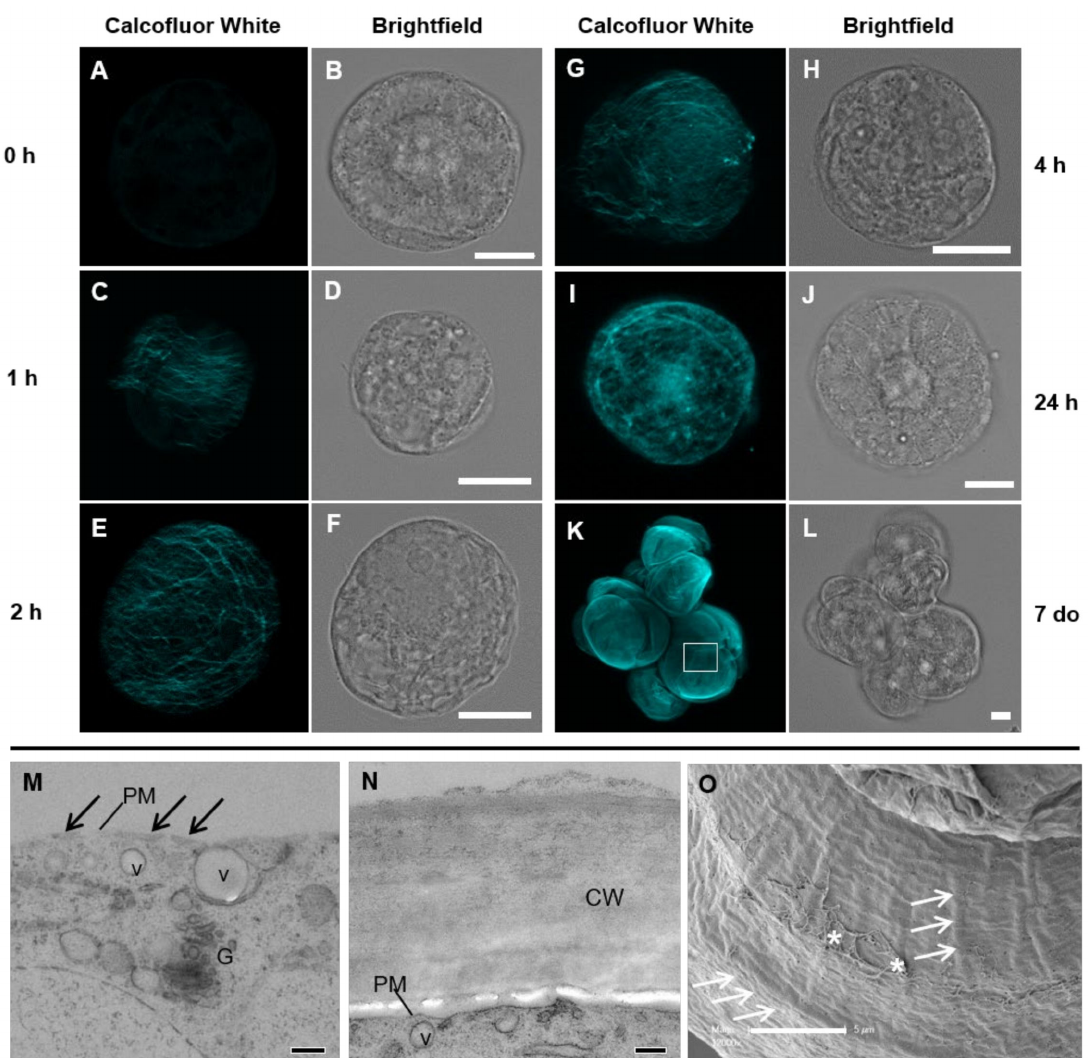
Figure 1. Images of the cell wall of Lolium suspension culture cells (SCC) during regeneration using the general cell wall stain Calcofluor White and laser scanning microscopy ( A – L ) and the cell wall detail using transmission ( M , N ) and scanning electron microscopy ( O ). The fluorescent images have had their brightness enhanced for easier visualization. Image K is a maximum projection of a z-stack of images and A, C, E, G, and I are single confocal sections of the cell wall. At the 0 h time point ( A , B ), minimal autofluorescence is observed. By 1 h ( C , D ), a number of fine filaments cover approximately half the protoplast. At 2 h ( E , F ), a loose fibrillar network encases the whole cell. At 4 h ( G , H ), the fibrillar network becomes more dense, which continues over the next 24 h ( I , J ). Actively growing Lolium SCC clump together in culture with a thick wall ( K , L ). Electron microscopy sections of the cell wall at 1 h after protoplasting ( M ) and in an unprotoplasted cell ( N ) show the difference in the cell wall structure. At 1 h, only nascent cell material is present (black arrows) at the plasma membrane (PM), while in unprotoplasted cells, the cell wall (cw) is approximately 1 µ m thick. Vesicles (v) and Golgi (G) are observed near the plasma membrane (PM). Detailed structure of the wall surface ( O ) from a position equivalent to the box in K, showing a variety of ridges (white arrows) and mucilage (asterisks). Scale bars = 10 µ m ( A – L ), 200 nm ( M , N ), and 5 µ m ( O